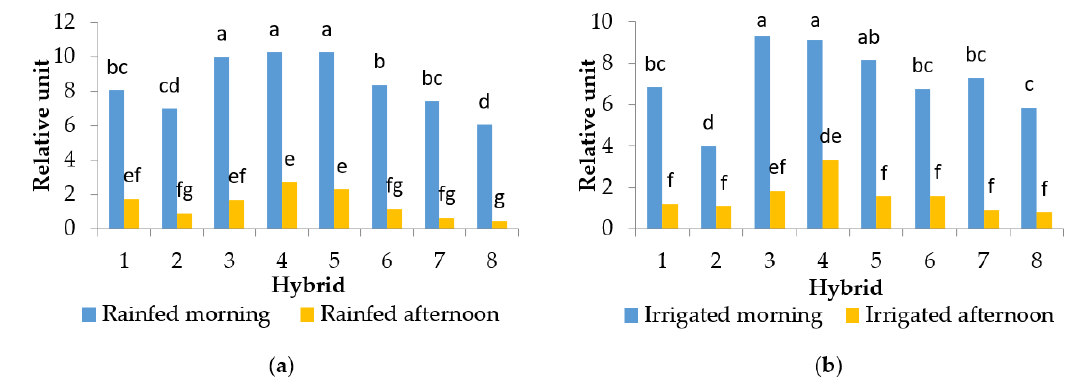
Figure 2. Mean values of the performance index (PI ABS ) in 2013 per hybrid depending on the treatments and the time of measurement: ( a ) rainfed in the morning and afternoon conditions, and ( b ) irrigated in the morning and afternoon conditions. Means with the same letter are not significantly different according to Tukey’s HSD test at p < 0.01. Table 1. Mean values of JIP-test parameters ( n = 24) for eight sunflower hybrids in the morning and afternoon conditions in 2013 and 2014. Means with the same letters in columns are not significantly different according to Tukey’s HSD 0.01 . Parameter/ Hybrid Year/